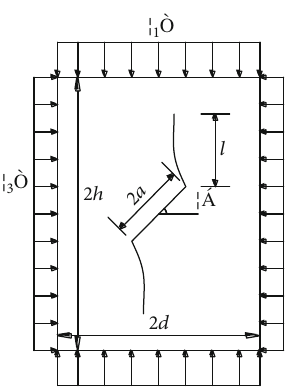
Figure 3: The sliding microcrack model under compression. 2 a and α are the length and dip angle of the microcrack, respectively. l is the wing crack length. 2 h and 2 d are the height and width of the model,